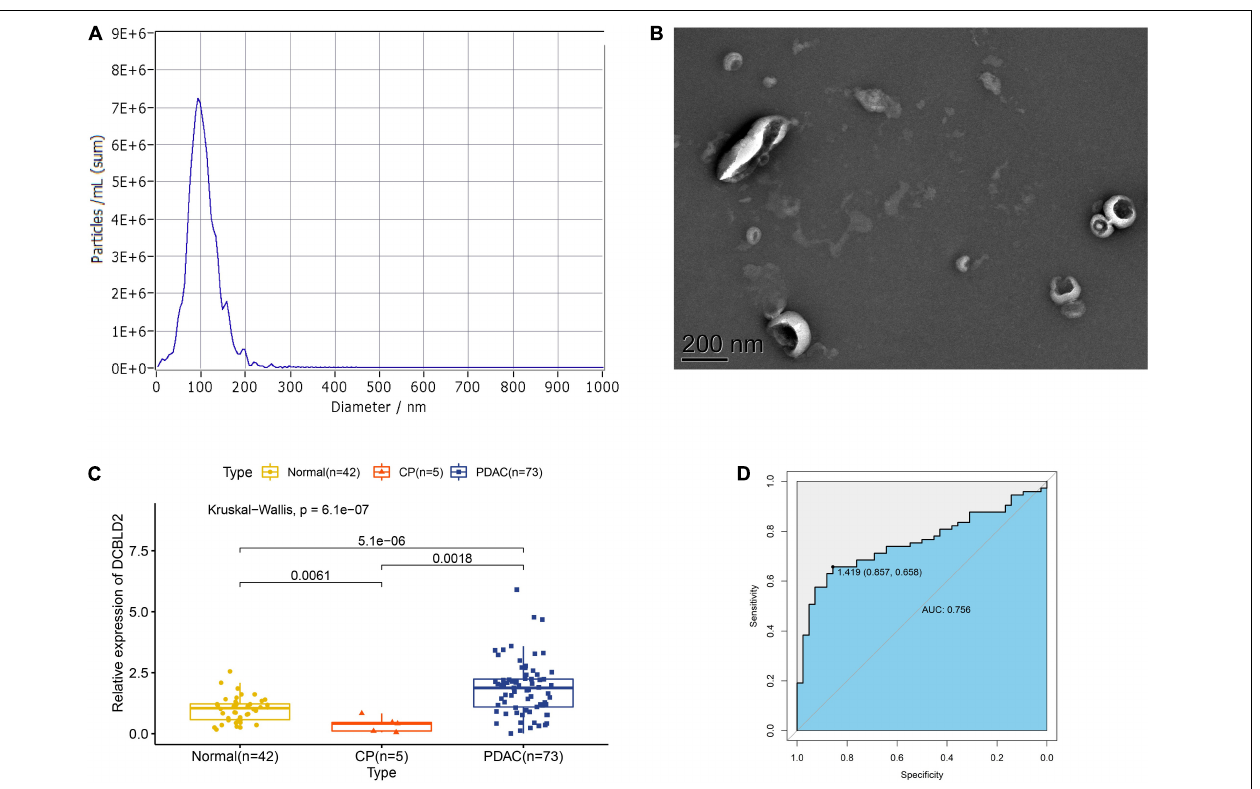
FIGURE 9 | Expression of DCBLD2 in extracellular vesicles from human serum samples. (A) NTA analysis and (B) TEM analysis to assess characteristics of extracellular vesicles. (C) Boxplots show the distribution of extracellular vesicular DCBLD2 expression in serum samples from healthy donors, CP patients and PDAC patients. (D) ROC curve showed the diagnostic value of extracellular vesicular DCBLD2 (PDAC vs Normal + CP). The statistical significance in comparing DCBLD2 expression between the two groups was determined by Wilcoxon test. The statistical significance in comparing DCBLD2 expression between the three groups was investigated by Kruskal–Wallis